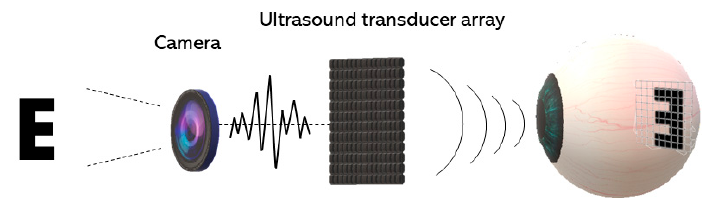
Figure 4. Scheme of an acoustic retinal prosthesis (ARP). The visual scene captured by an external camera is processed and transmitted to an ultrasound transducer array for stimulation in the retina.